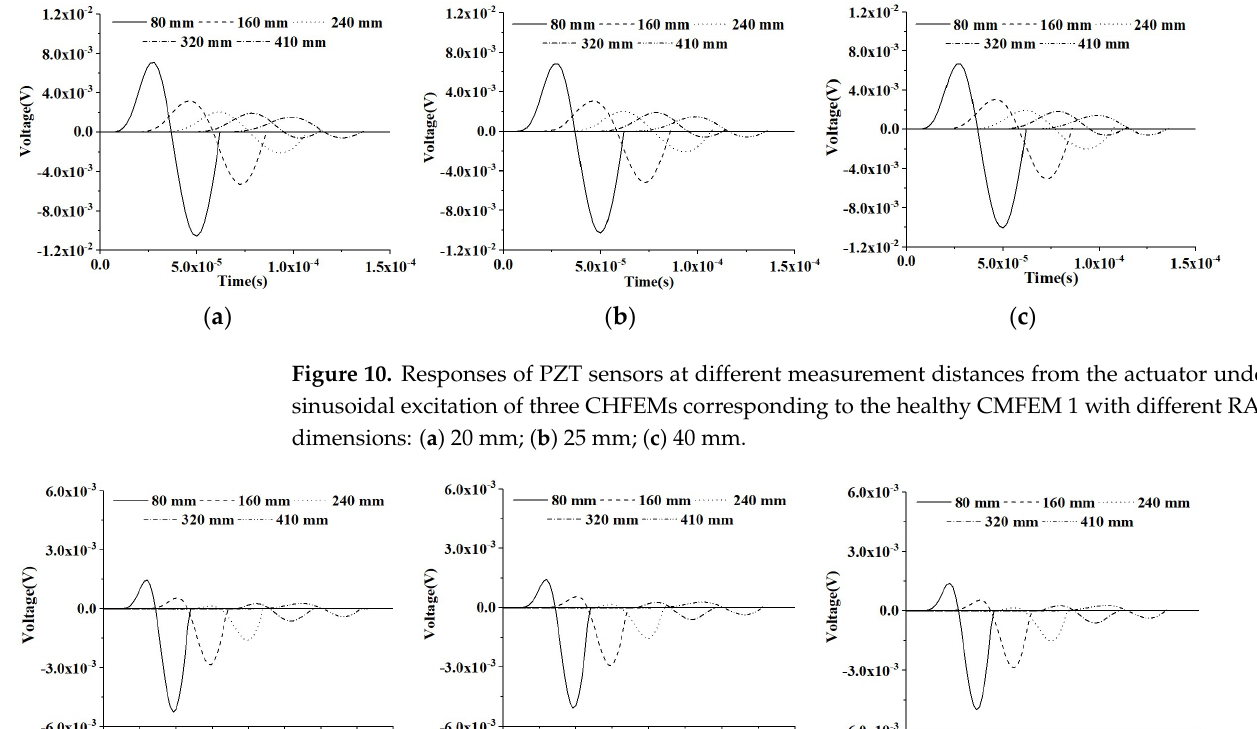
( c ) Figure 9. Output voltage collected by sensors at different measurement distances from the actuator under a modulated sinusoidal excitation signal for CMFEMs with an interface debond defect. ( a ) CMFEM 1D; ( b ) CMFEM 2D; ( c ) CMFEM 3D. 5.2. Comparison of Responses of PZT Sensors with Different CHFEM Measurement Distances with Different RAE Dimensions In the previous study by the authors of [35], the influence of the mesoscale concrete core of the RCFST on a PZT sensor at a certain distance from the actuator is studied with a CHFEM with a certain RAE dimension. Here, the responses of PZT sensors at the differ- ent measurement distances of three CHFEMs with different square RAE side dimensions including 20 mm, 25 mm and 40 mm are further investigated. Without a loss of generality, in this section, the results of the three CHFEMs corresponding to CMFEM 1 are described. 5.2.1. PZT Sensor Measurements under Sinusoidal Input Signal of CMFEMs Figure 10 shows the time-domain response of PZT sensors at different measurement distances of the healthy CHFEMs corresponding to the CMFEM 1 without an interface